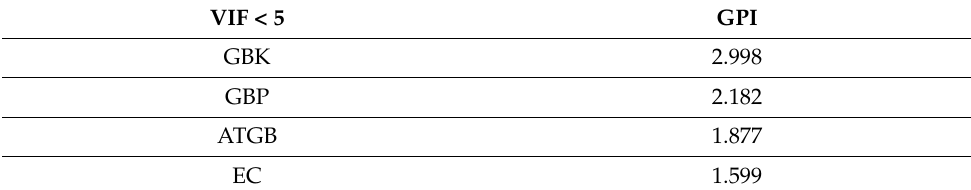
Table 6. Collinearity Assessment for Inner model (Variance inflation factor (VIF) values).